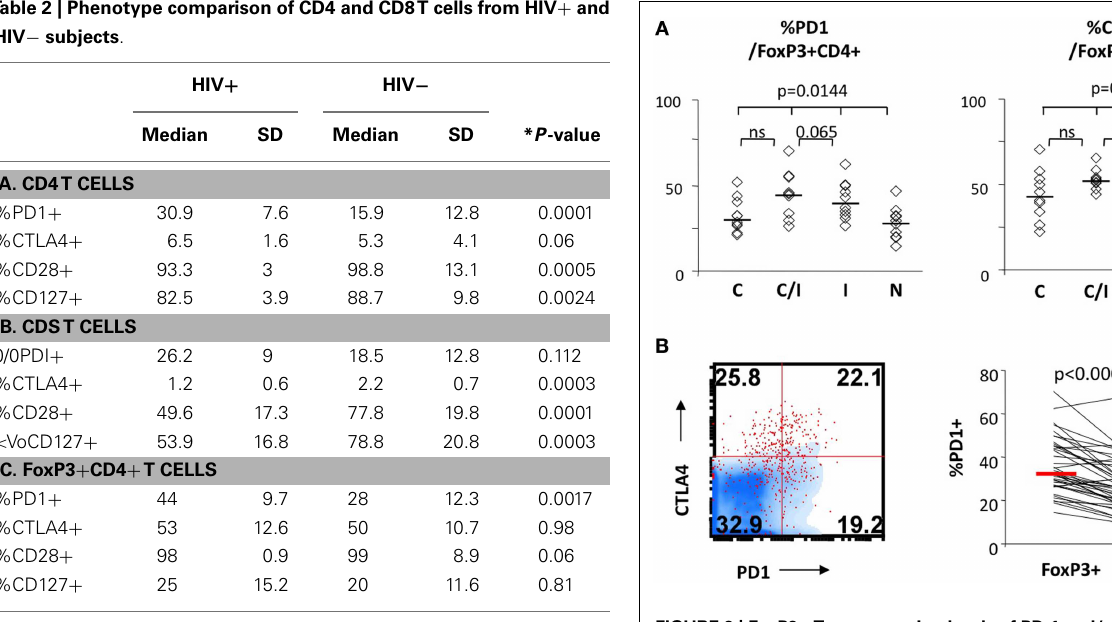
Supplementary Material) but not with CD4 T cell frequency or co-stimulatory receptor expression on CD4 and CD8 T cells (data not shown). We also did not find an association between HIV viral load and FoxP3 + Treg frequency. For example, FoxP3 + Treg frequency did not differ between HIV-seropositive patients with and without active HIV viremia (Figure S2C in Supple- mentary Material, left panel). Furthermore, FoxP3 + Treg fre- HIV-viremic patients (Figure S2C in Supplementary Material, middle panel), and it remained higher in HCV/HIV-coinfected patients with undetectable HIV viremia compared to HIV- monoinfected patients with undetectable HIV viremia and HCV- monoinfected patients (Figure S2C in Supplementary Material, right panel).